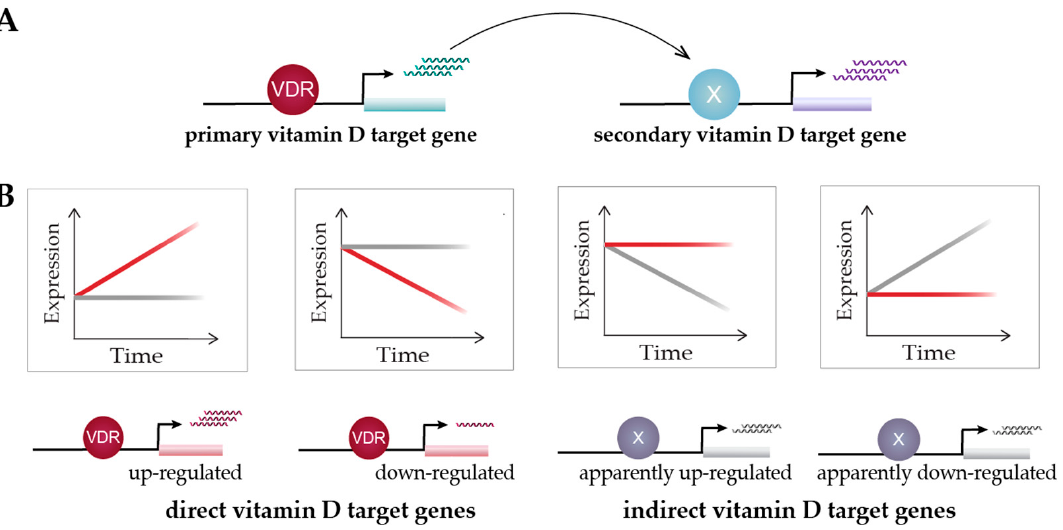
Figure 3. Classification of vitamin D target genes. Primary vitamin D target genes are directly regulated by VDR, while secondary vitamin D targets are controlled by transcriptional regulators that are encoded by primary targets ( A ). Time course analysis allows to differentiate vitamin D target genes in four different types based on cause and direction of expression change [108] ( B ). This suggests an alternative view on vitamin D signaling: 1,25(OH) 2 D 3 either directly induces or reduces the expression of its target genes via VDR or prevents their expression change mediated by other factors. Red and grey lines indicate gene’s expression level in the presence or absence of 1,25(OH) 2 D 3 , respectively.